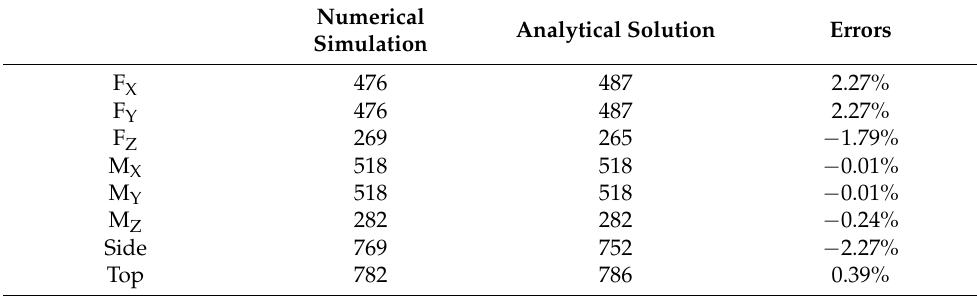
Table 4. Normal strain analysis on the beam of the elastic body: numerical vs. analytical on 5